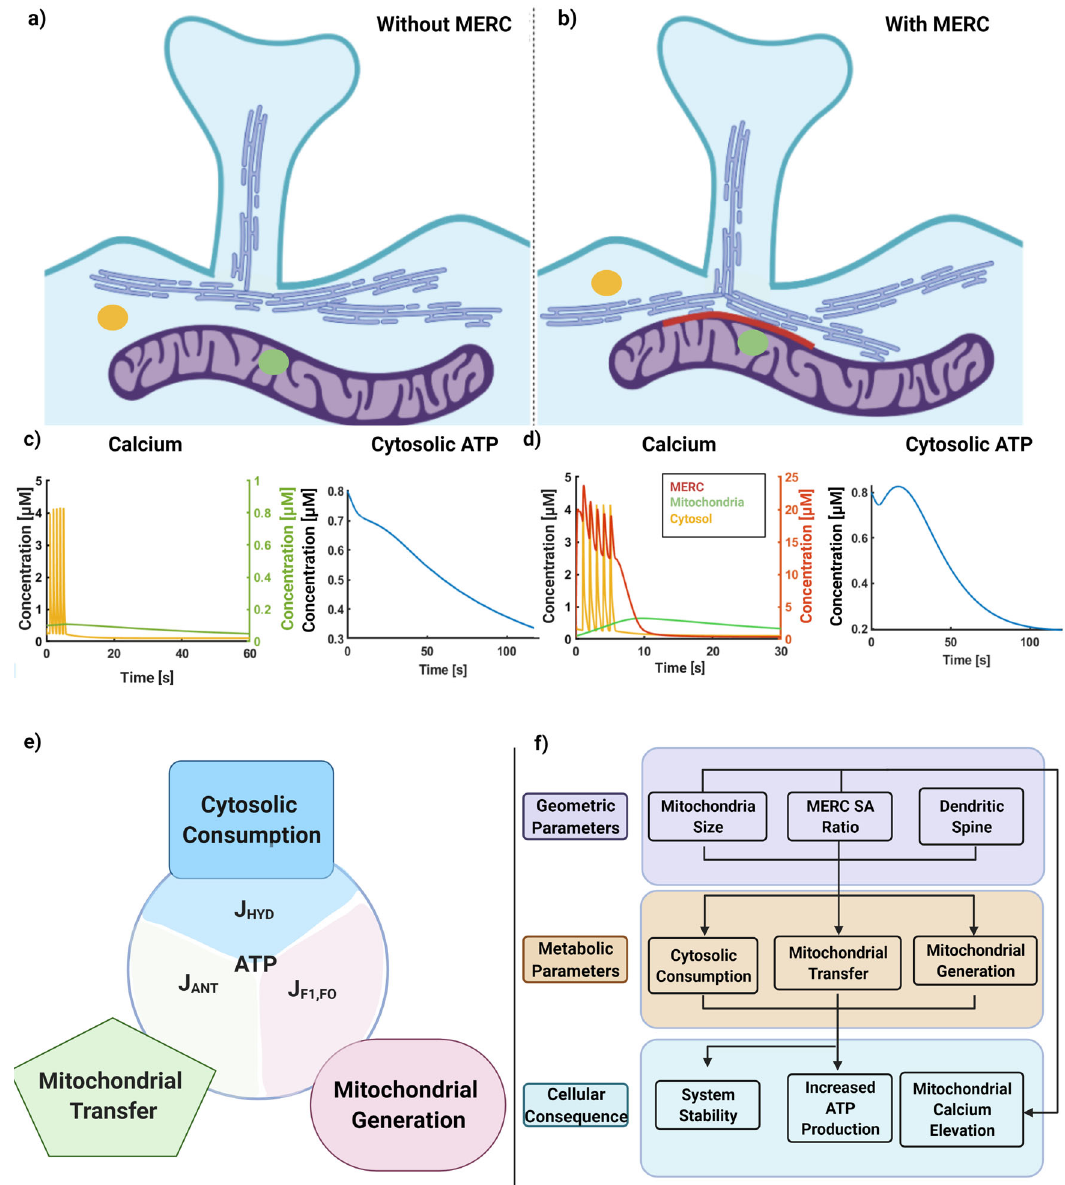
Fig. 8 Impact of MERCs and geometric regulation of mitochondrial ATP production. a ) Schematic for dendrite with ER not forming contacts with mitochondria. b ) Schematic for dendrite with ER forming contacts with mitochondria, highlighted in red. c ) i ) Calcium pro fi les for cytosol (in yellow) and mitochondria (in green) for the system without any contact sites. ii ) ATP pro fi les in the cytosol for the system without any contact sites. d ) i ) Calcium pro fi les for cytosol (in yellow), mitochondria (in green), and MERC (in red) for system with contact sites. e ) Schematic outlining key fl uxes that balance ATP in the mitochondria and cytosol explored in Fig. 7. f ) Flow diagram describing the interconnected in fl uence of cell and organelle geometry on ATP production with added feedback through calcium signaling. Figure created using